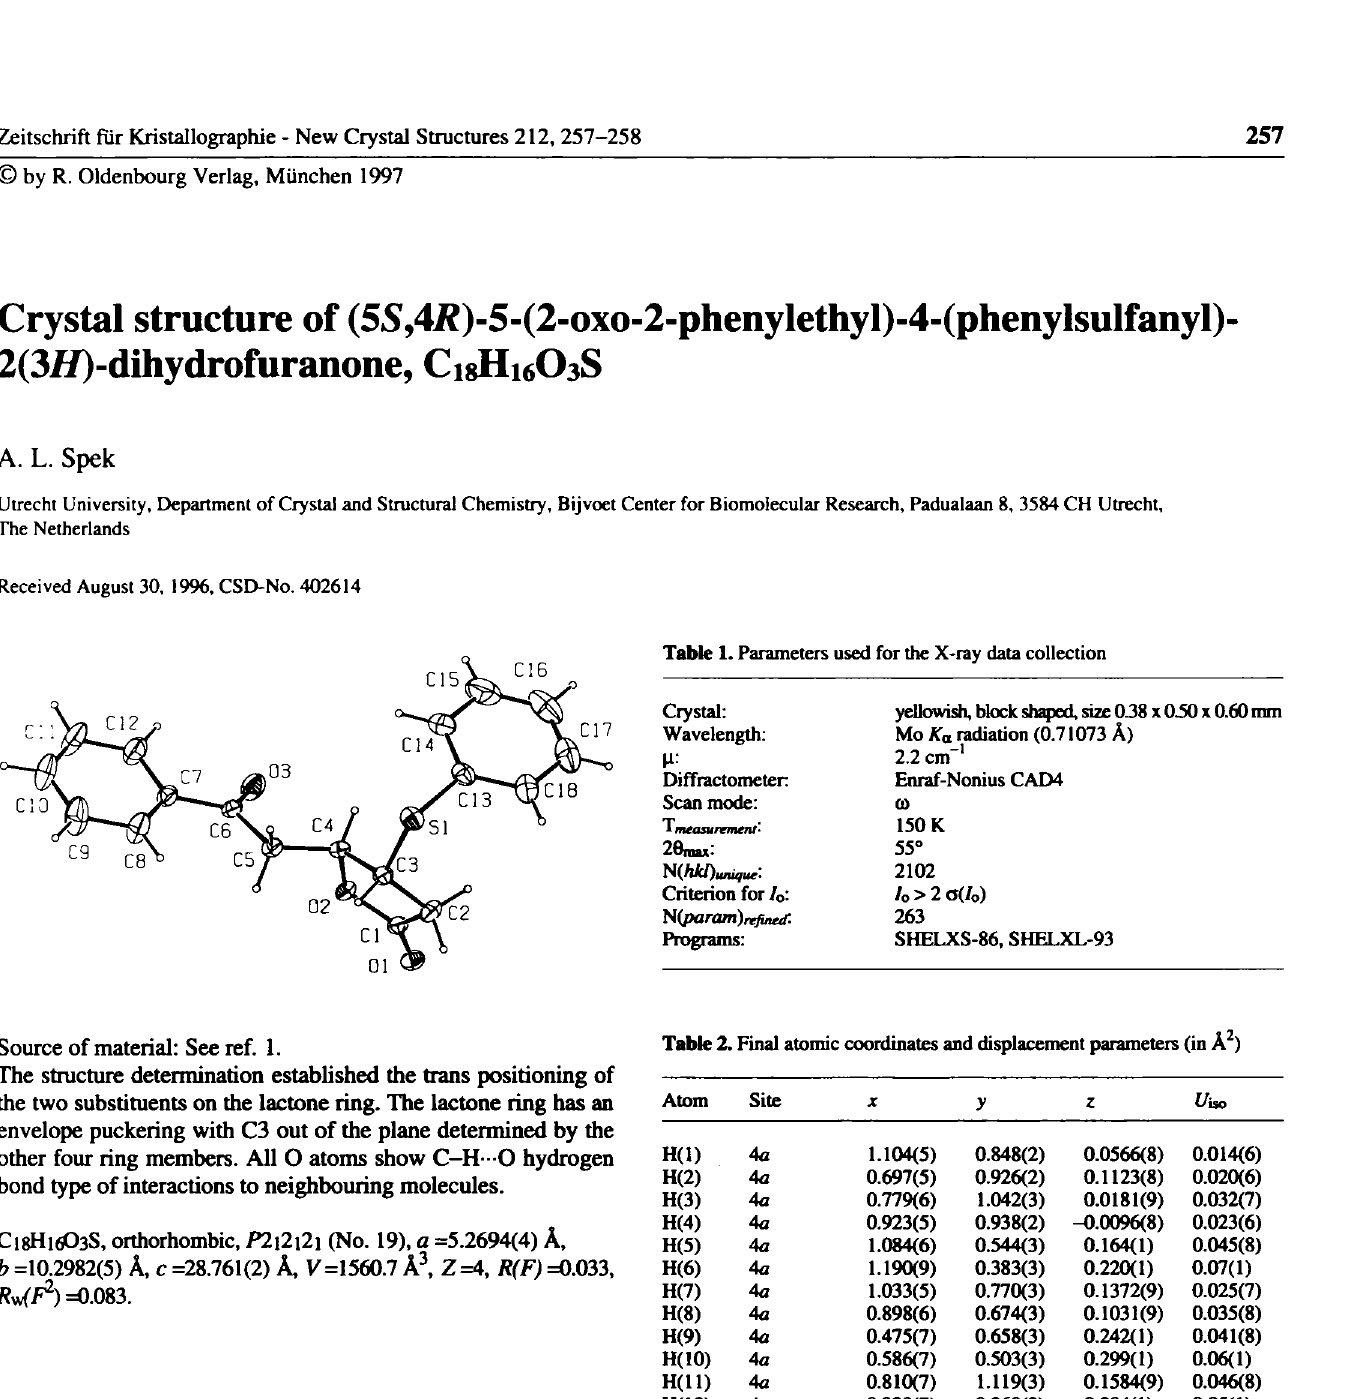
Table 3. Final atomic coordinates and displacement parameters (in A 2 )